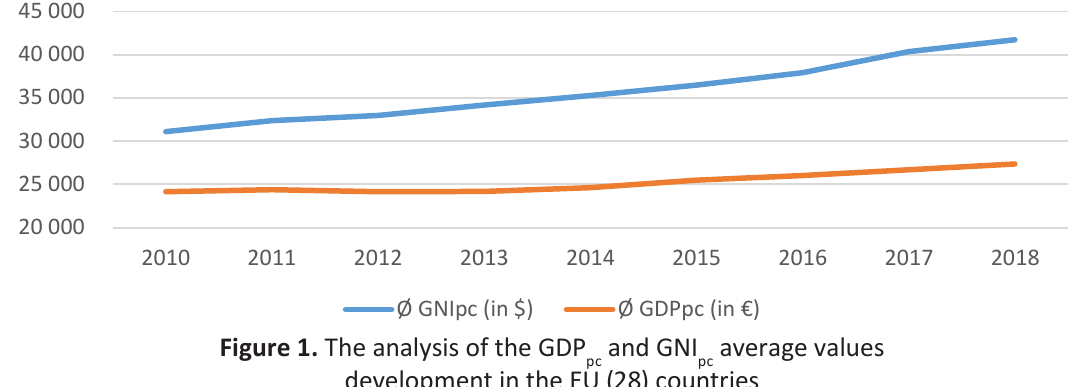
and GNI average values pc pc